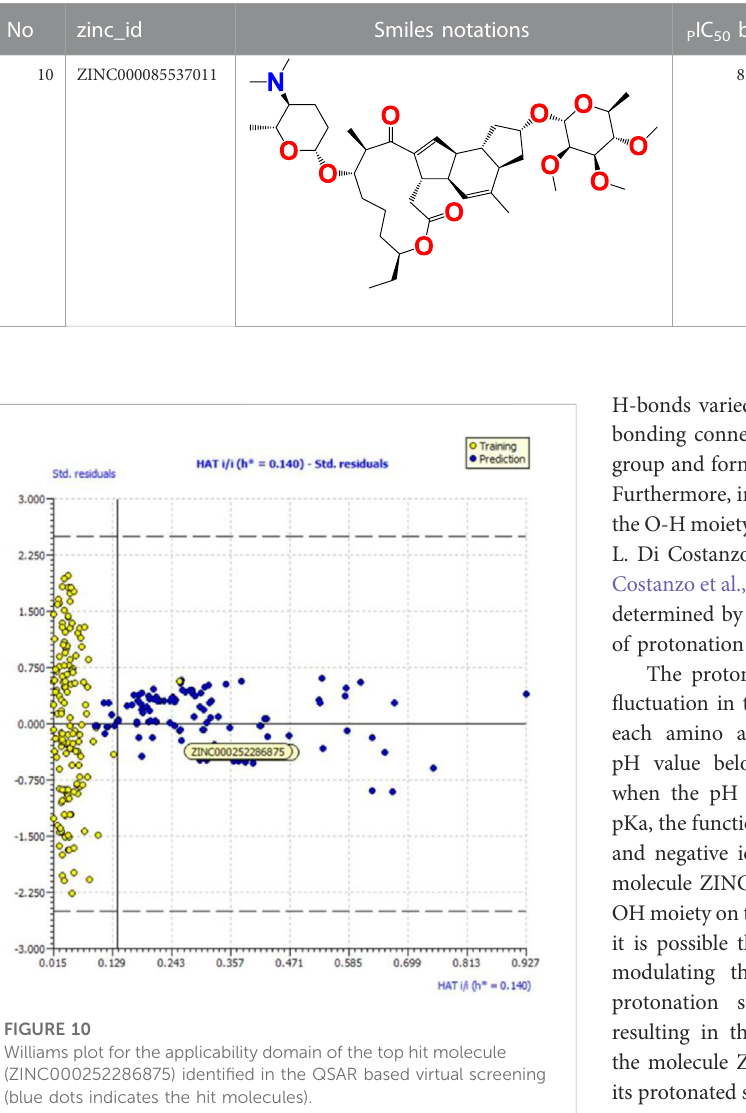
TABLE 3 ( Continued ) Presentation of zinc id, structures, P IC 50 Predicted by QSAR vs, Docking Score (Kcal/mol), and RMSD(Å) for top 10 FDA molecules.